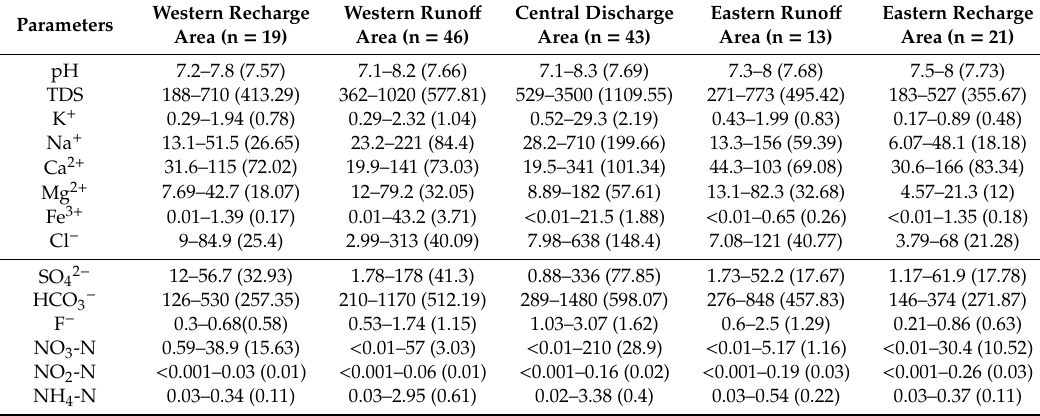
Table 1. Statistics of groundwater chemical data in each hydrogeochemical zone (in mg / L, figures in parentheses represent mean values).